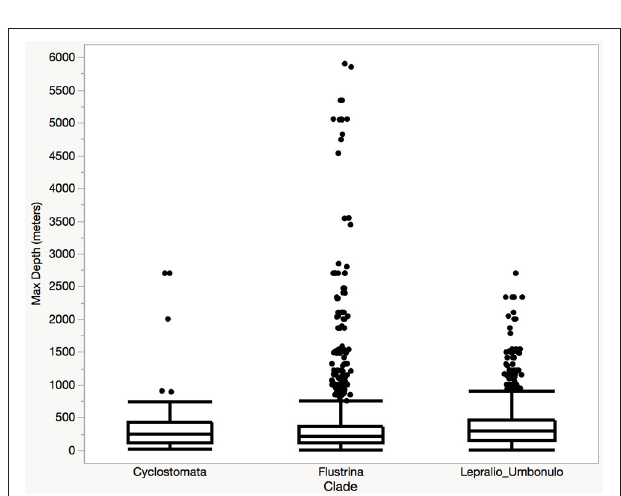
FIGURE 8 | Worldwide depth distributions of bryozoans grouped by